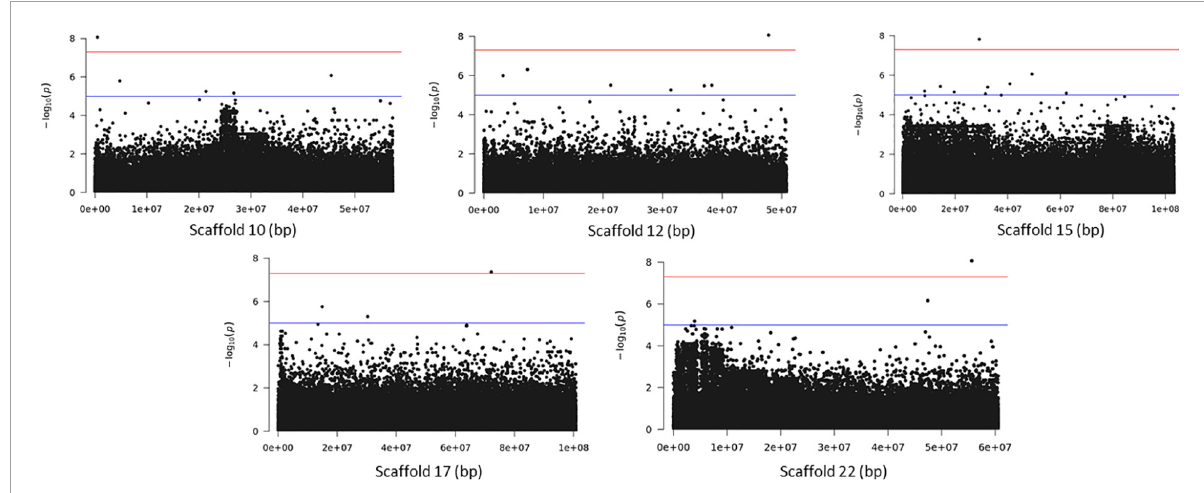
FIGURE8 Genome Wide Association Analysis on the top part of bamboo. Manhattan plots of scaffolds harboring SNPs with p ≤ 10 − 7 .